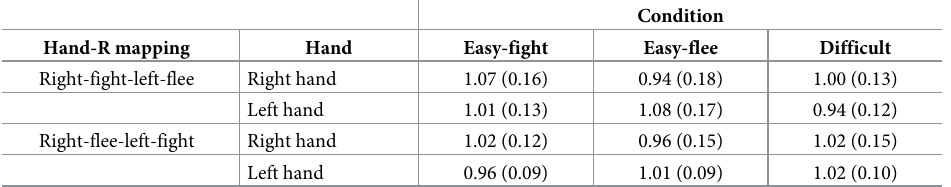
Table 2. Normalized mean MEPs (and